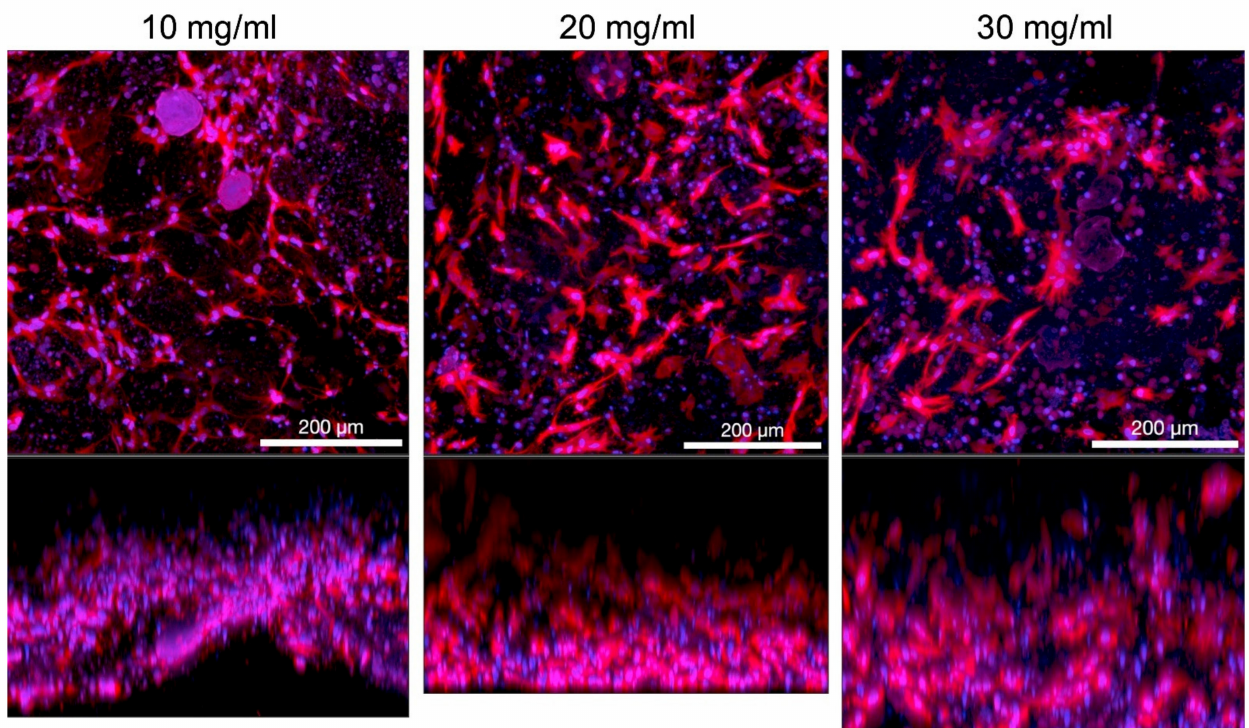
Figure 6. Porcine stromal cells in 3D printed collagen hydrogel with concentrations 10, 20 and 30 mg/mL substrate coverslip glass, red F-actin, blue cell nuclei. Top row shows maximum intensity projection and bottom row show side projection from confocal microscopy. The microscopy images were acquired on Andor Dragonfly spinning disk confocal system with high-speed CMOS camera Zyla 4.2 (Andor Technology Ltd., Belfast, UK) mounted on Leica DMi8 inversed fully mechanized microscope (Leica, Wetzlar, Germany) using 20 × lens (NA = 0.75) with water immersion. The wavelengths of the excitation lasers were 405 nm and 561 nm and the transmission characteristics of the emission filters were 450/50 nm and 600/50 nm. Used disk pinhole diameter was 40 µ m. The hydrogel samples were photographed in PBS buffer in 35 mm Petri dish with